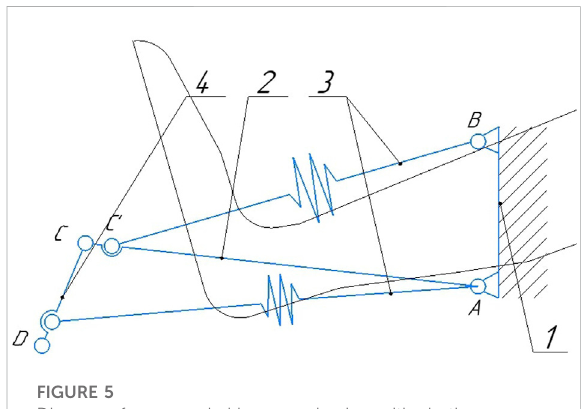
FIGURE 5 Diagram of a suspended lever mechanism with elastic elements 1 — fastening of the orthosys, 2 — horisontal lever, 3 — elastic elements, 4 — movable lever.